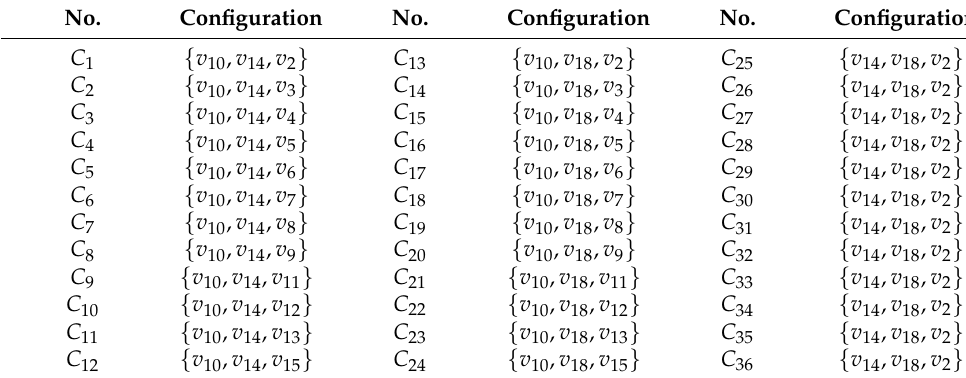
Table 5. Experiment’s additional configurations of the reactions fluxes apart from C 0 = { v 10 , v 14 , v 18 } . No. Configuration No. Configuration No. Configuration C 1 { v 10 , v 14 , v 2 } C 13 { v 10 , v 18 , v 2 } { v 14 , v 18 , v 2